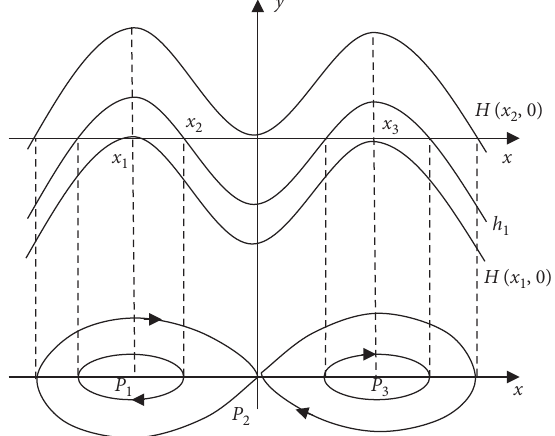
Figure 2: − F ( x ) function curve and periodic trajectories when h q � 0 and Δ <